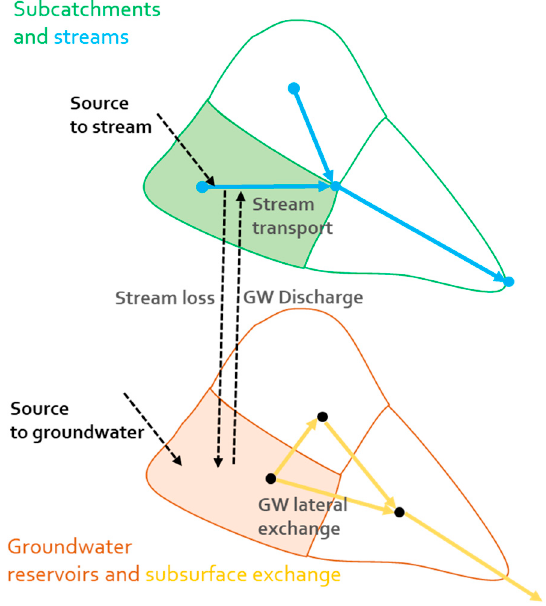
Figure 1. Schematic of the model spatial arrangement and exchanges. The shading indicates a matching subcatchment and its underlying reservoir.